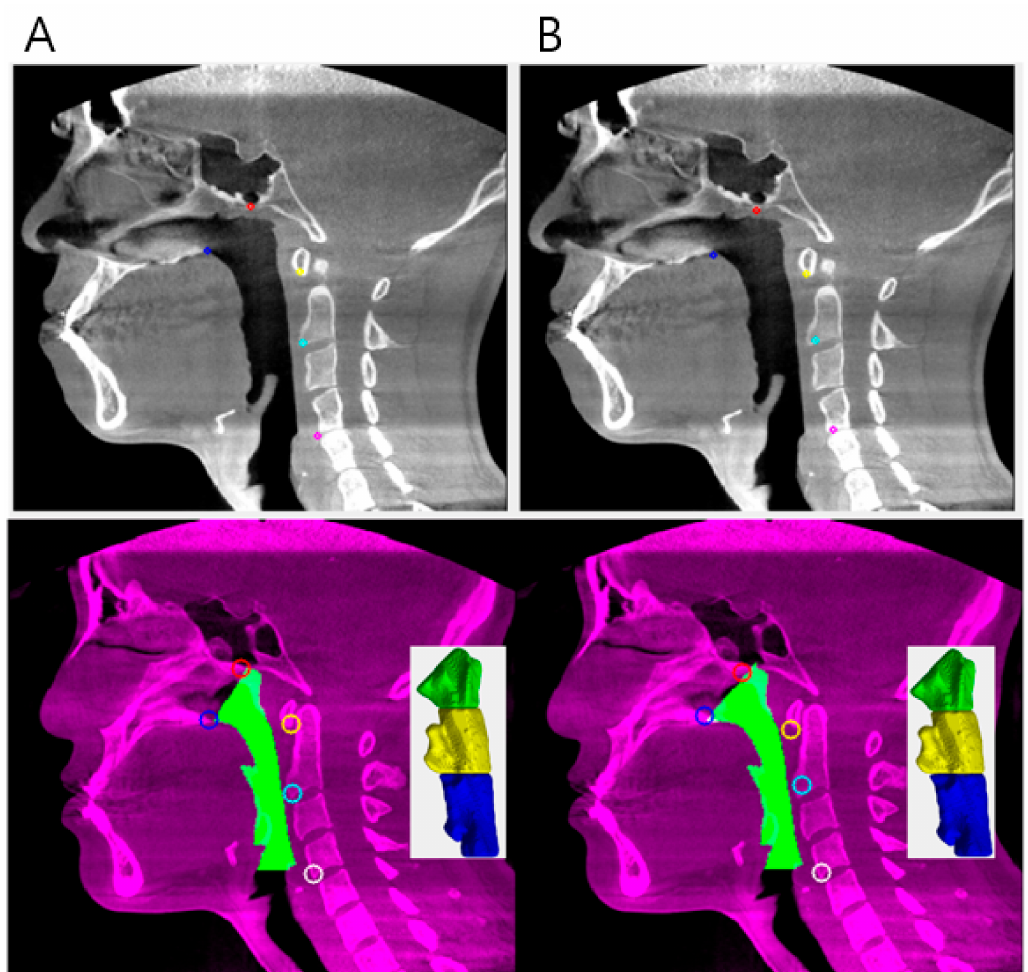
Figure 3. ( A ) Example of manually pointed data and its volume segmentation. ( B ) Example of deep learning pointed data and its volume